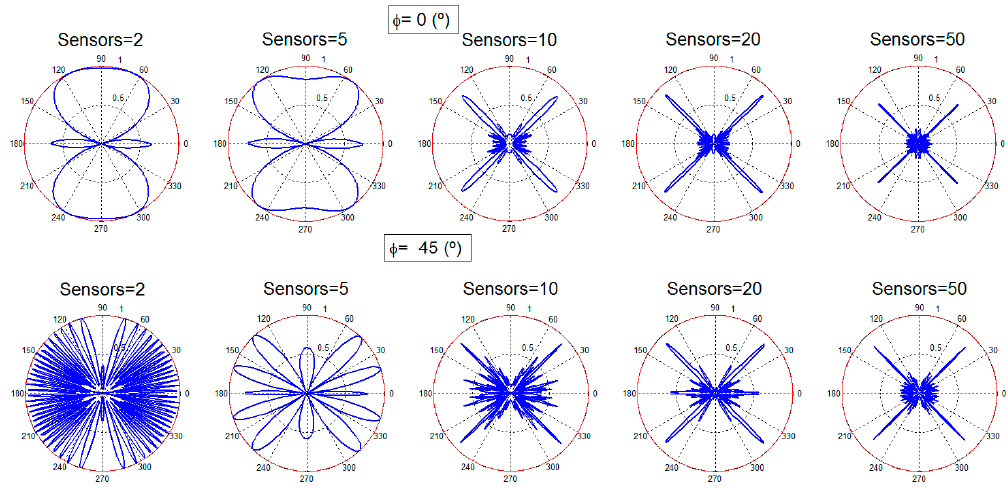
Figure 2. Radiation patterns for two, five, 10, 20 and 50 sensors, different search angles: isotropic